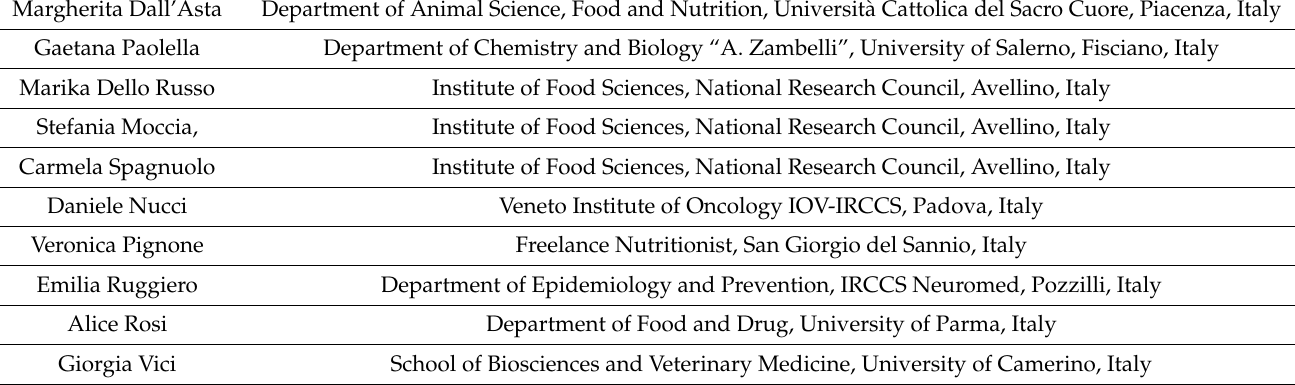
Table A1. SINU Young Working